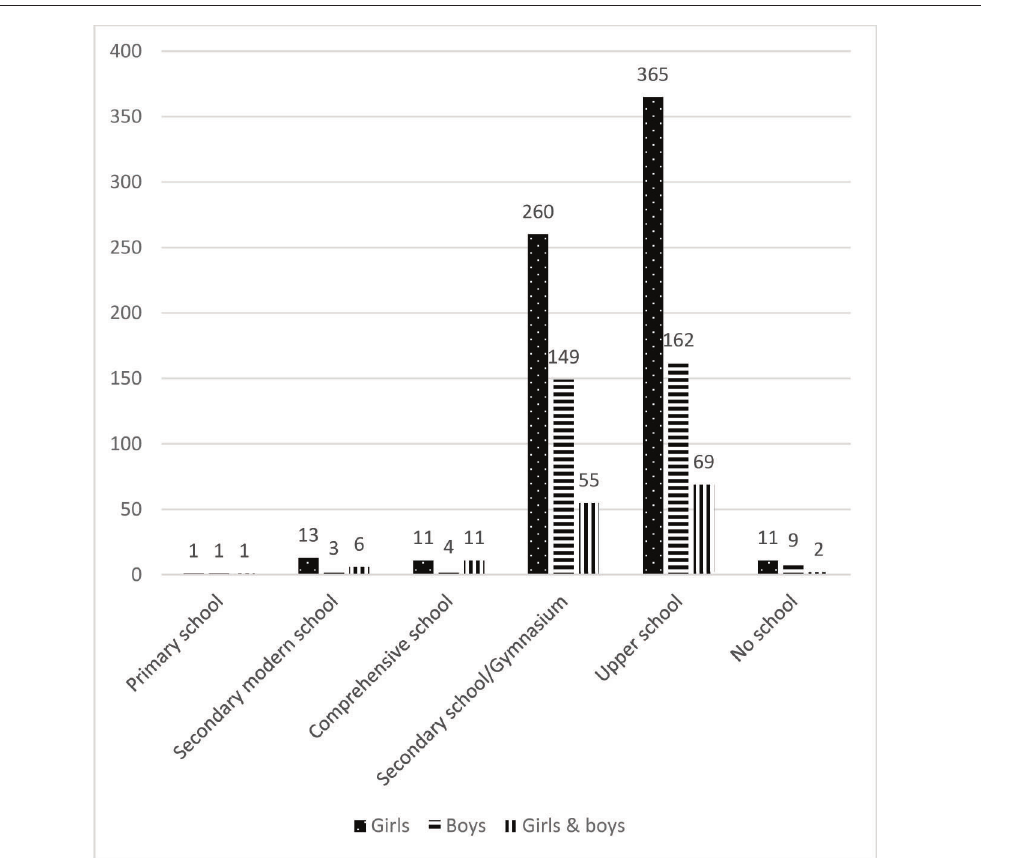
Figure 1: Educational context of participants in the